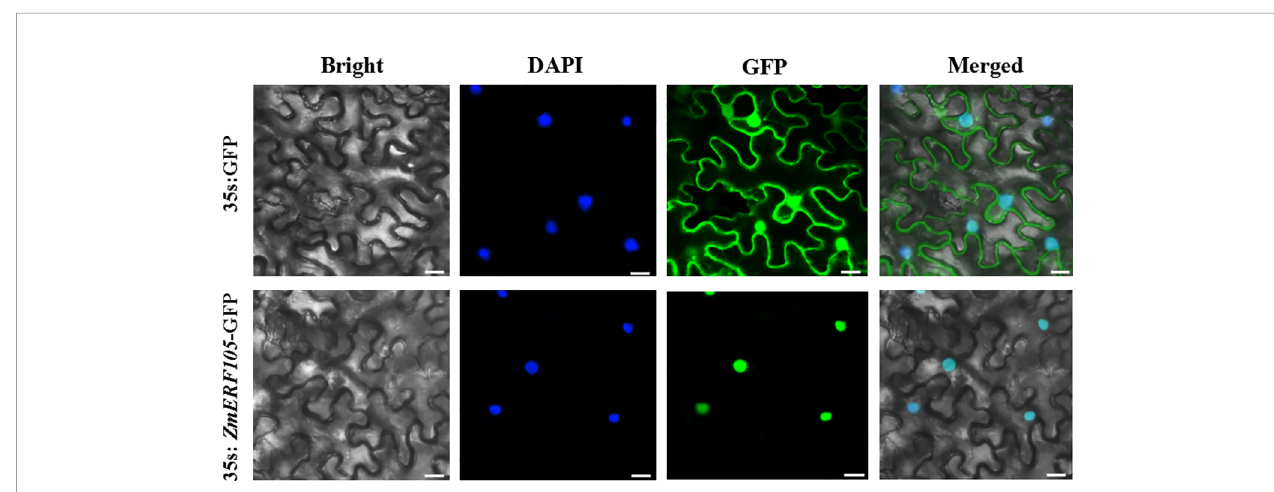
FIGURE 4 | Subcellular localization of ZmERF105-GFP fusion protein in the epidermal cells of N. benthamiana . N. benthamiana leaves transiently expressing GFP alone (upper) and ZmERF105-GFP (bottom) proteins were observed with a confocal microscope. Bars = 25 m m.